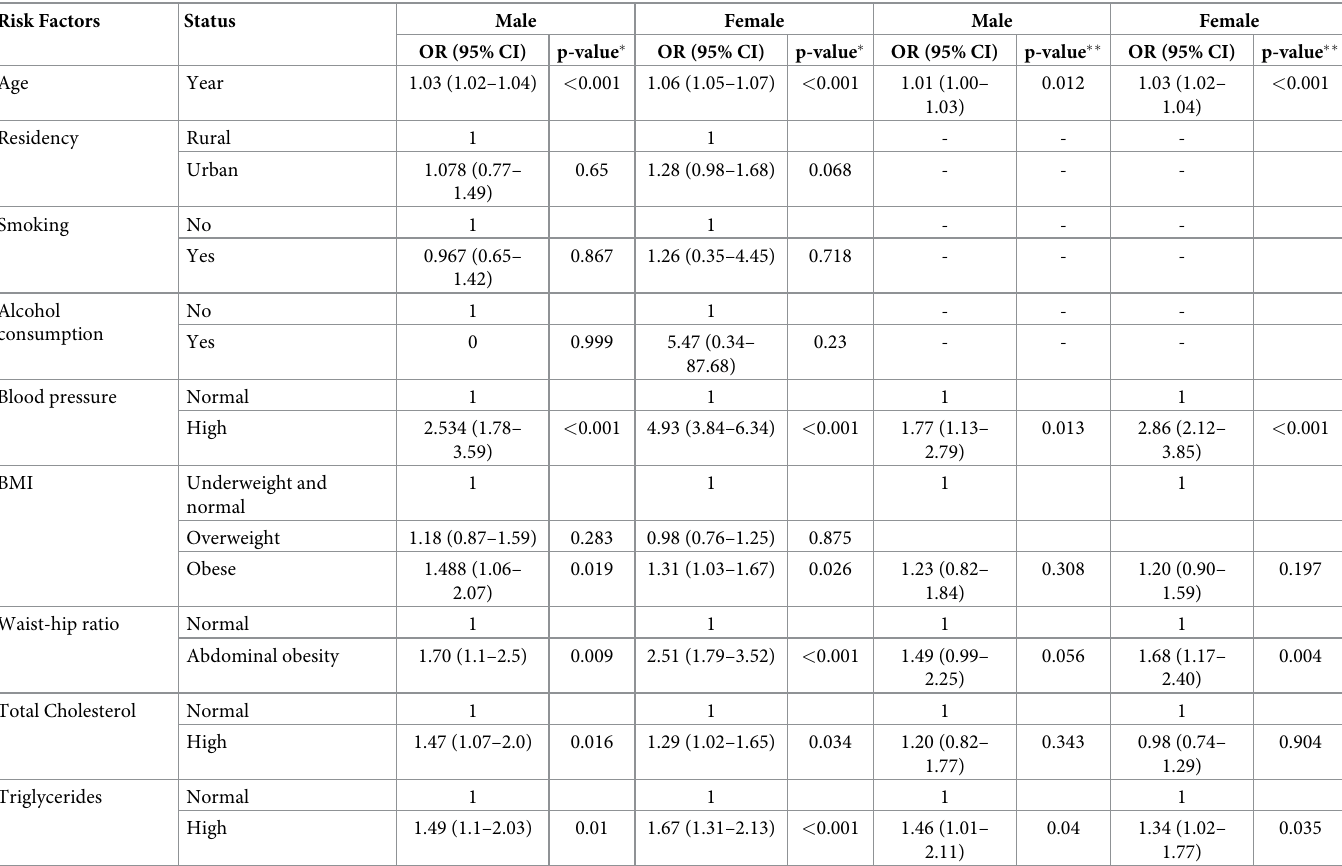
Table 3. The odds ratio of risk factors for developing T2DM by